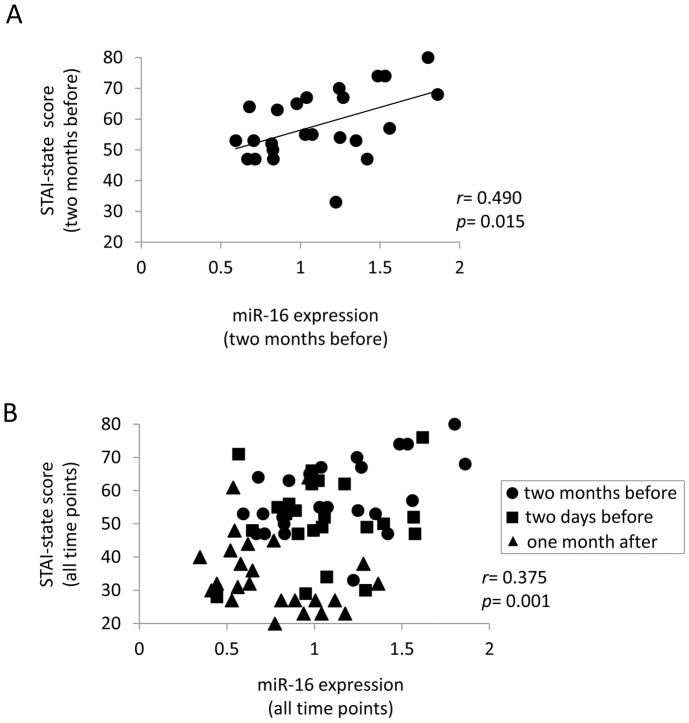
Correlation between miR-16 levels and STAI-state scores.(A) Correlation between miR-16 and STAI-state scores two months before the examination in 25 students was analyzed by Pearson correlation coefficients. miR-16 levels normalized by RNU48 were significantly and positively correlated with STAI-state scores. (B) Correlation between miR-16 levels and the state anxiety scores measured in all three time points in 25 students was analyzed by Pearson correlation coefficients. The closed circle, square, and triangle indicate two months before, two days before, and one month after the examination, respectively.